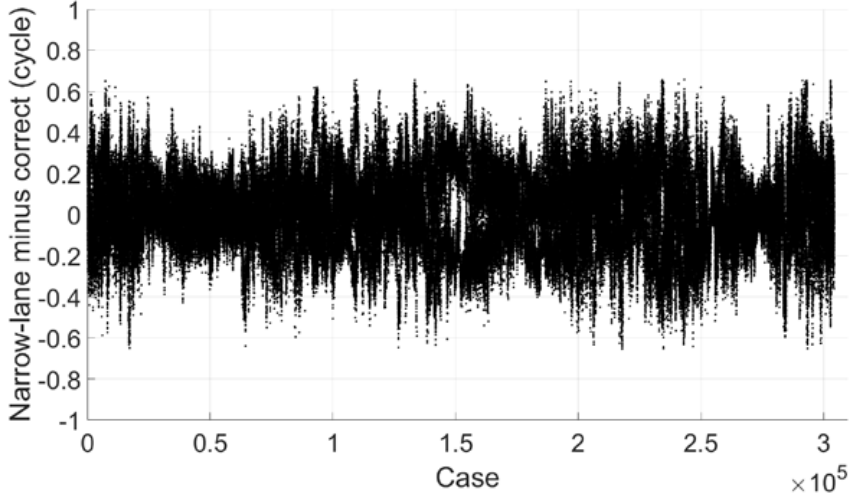
Figure 16. Narrow-lane ambiguity minus correct integer ambiguity (Galileo).